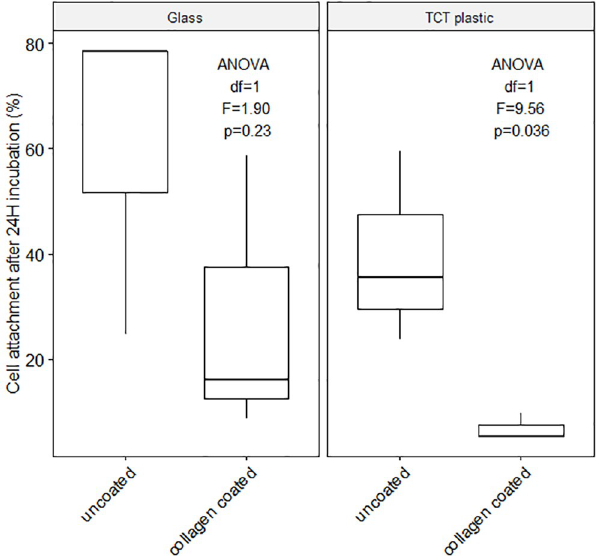
Fig 5. Cell attachment. Average cell attachment (%, miscellaneous Pocillopora acuta cells) on glass and tissue culture- treated (TCT) plastic, with and without collagen coating after 24H incubation at 25˚C and 12 h light / 12 h dark cycle, S1 Table. (Initial cell dissociation: Ca 2+- Mg 2+ free seawater incubation for 1 hour; Culture medium combination use: 15% DMEM, 5% FBS, 1% Penicillin-Streptomycin, 79% sterile filtered artificial seawater, see S5 Table). Significant difference between coated and uncoated substrate (df = 1, F = 6.34, p = 0.036) but no significant difference between TCT plastic and glass (df = 1, F = 2.64, p = 0.143) S5 Table.